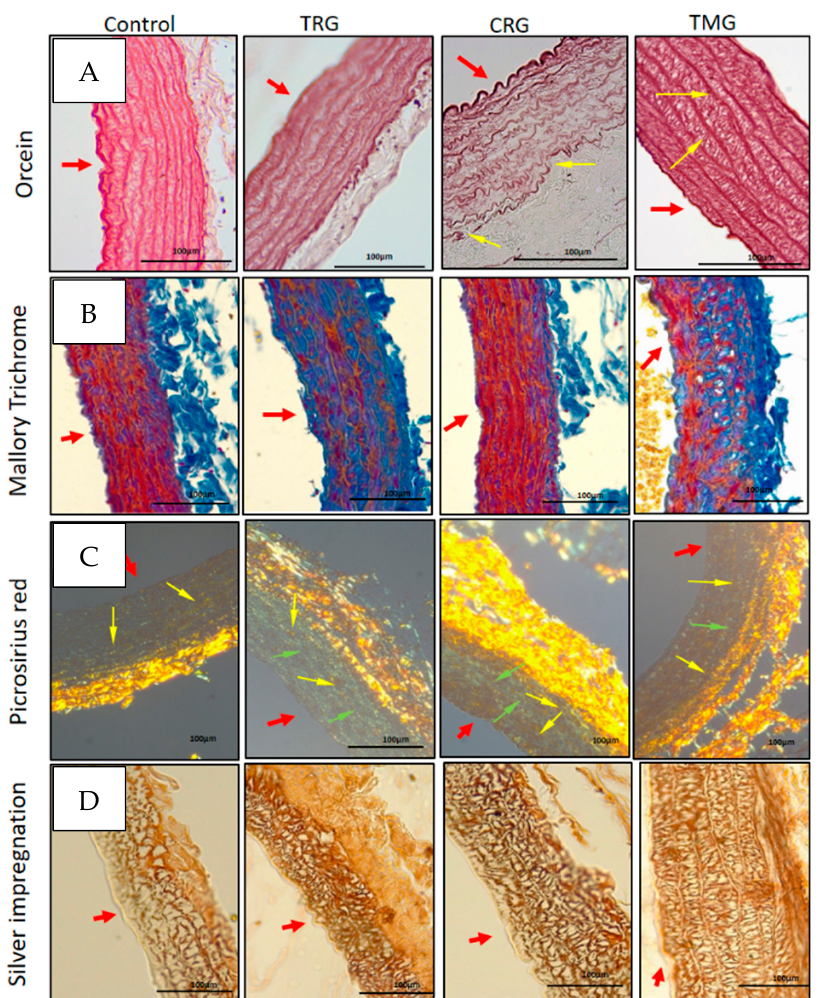
Figure 4. Visualization of elastic ( A ) and collagen fibers ( B – D ). Red arrows indicate aortal intima. ( A ): yellow arrows indicate fragmentation of elastic fibers in lamellae in CRG and thickening of elastic lamellae in media in TRG groups; ( B )—collagen fibers accumulation in media (deep blue); ( C )—collagen type I with yellow color and strong birefringence (yellow arrows) and collagen type III with greenish color and weak birefringence (green arrows); ( D )—type III collagen in aortal media ( D ). Orcein staining ( A ); Mallory trichrome staining ( B ); Picro-Sirius Red—Polarizing microscopy( C ); Silver impregnation ( D ). Objective magn. ×40; bar 100 μ m.